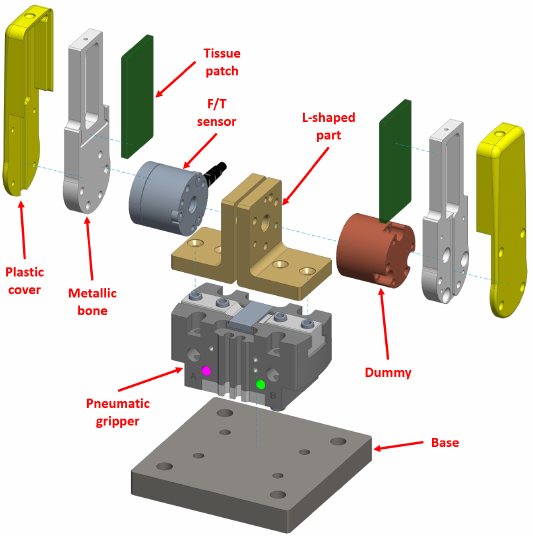
Figure 2. Exploded view of the instrumented prototype. The pneumatic gripper mounted on the base was the commercial device (CGPT20) upon which the whole instrumented prototype was built.